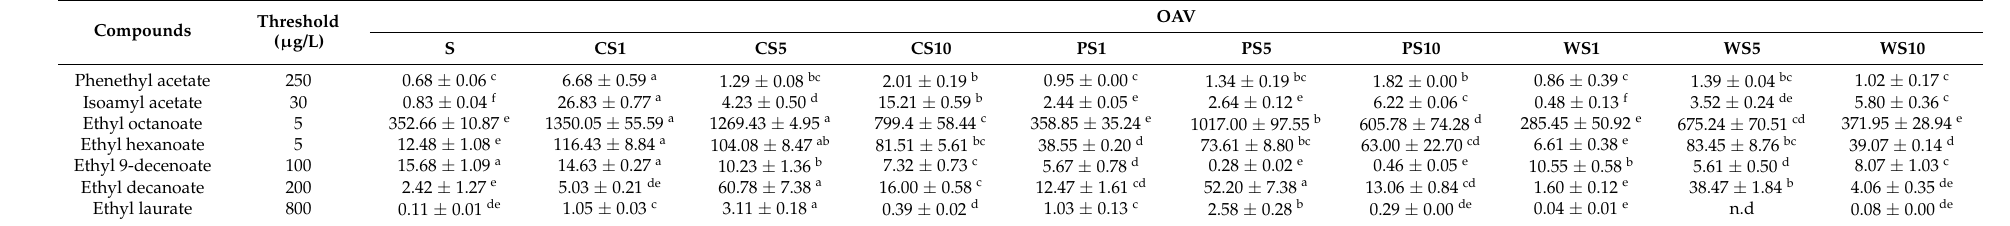
Table 2. Volatile odor active compounds (OAV > 1) in fermentation samples during the simulated fermentation of fruit